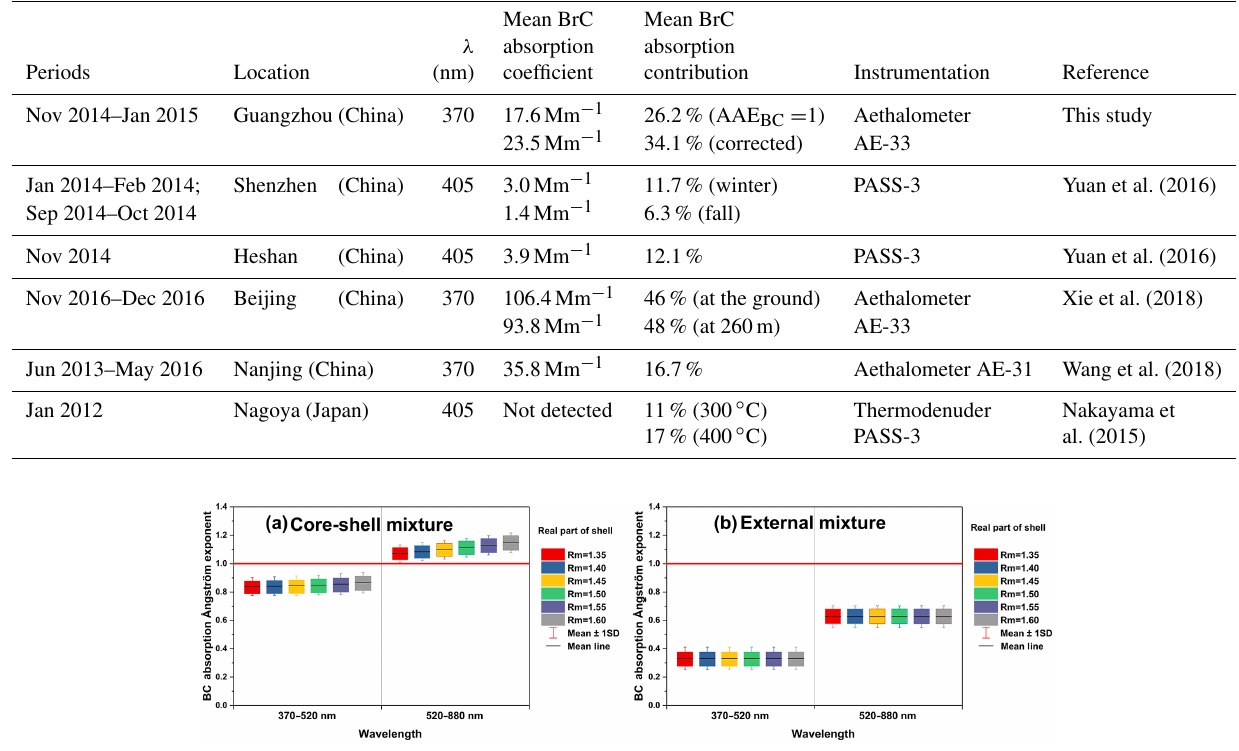
Figure 3. Influence of the wavelength-independent refractive index of the non-absorbing materials on the (a) AAEs of the core–shell mixture and (b) AAEs of the external mixture with a constant BC core refractive index ( e m core = 1 . 80–0.54 i ). The imaginary part of the non(less)- absorbing shell was set to 10 − 7 , while the real part varied from 1.35 to 1.60. In each panel, the boundaries of the box represent the 75th and 25th percentiles; the whiskers above and below each box indicate an error of 1 standard deviation; the black lines in the boxes denote the average values. In panels (a) and (b) , the red line indicates where AAE BC =